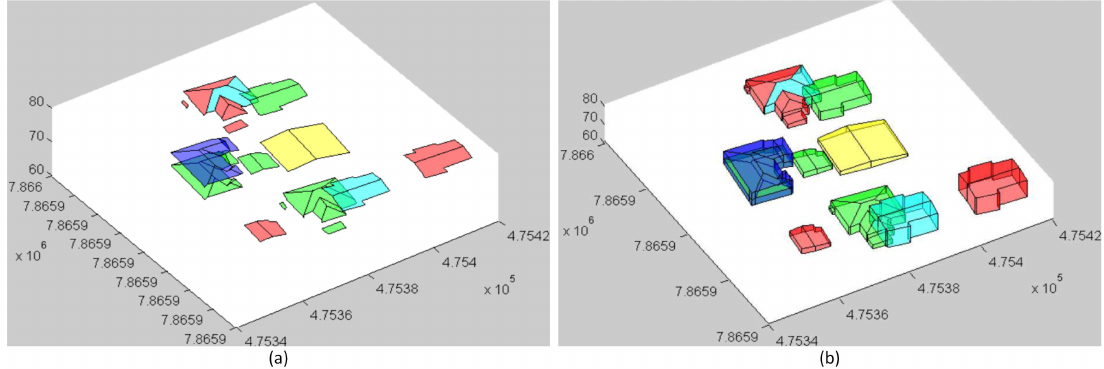
Figure 14. Classification of building planes into five groups, i.e., unchanged (yellow), new (red), modified (blue), partially-modified (cyan) and demolished (green) planes: ( a ) roof planes only; and ( b ) roof and wall